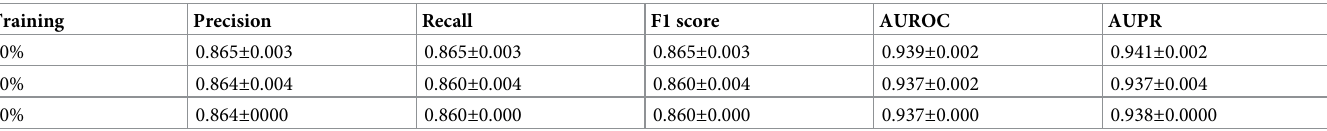
Table 3. Comparing different percentage of the training set in the GCNMLP. Training